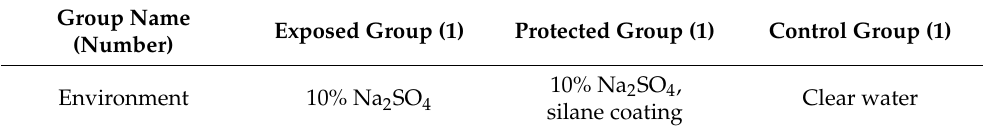
Table 2. Specimen grouping and curing environment.